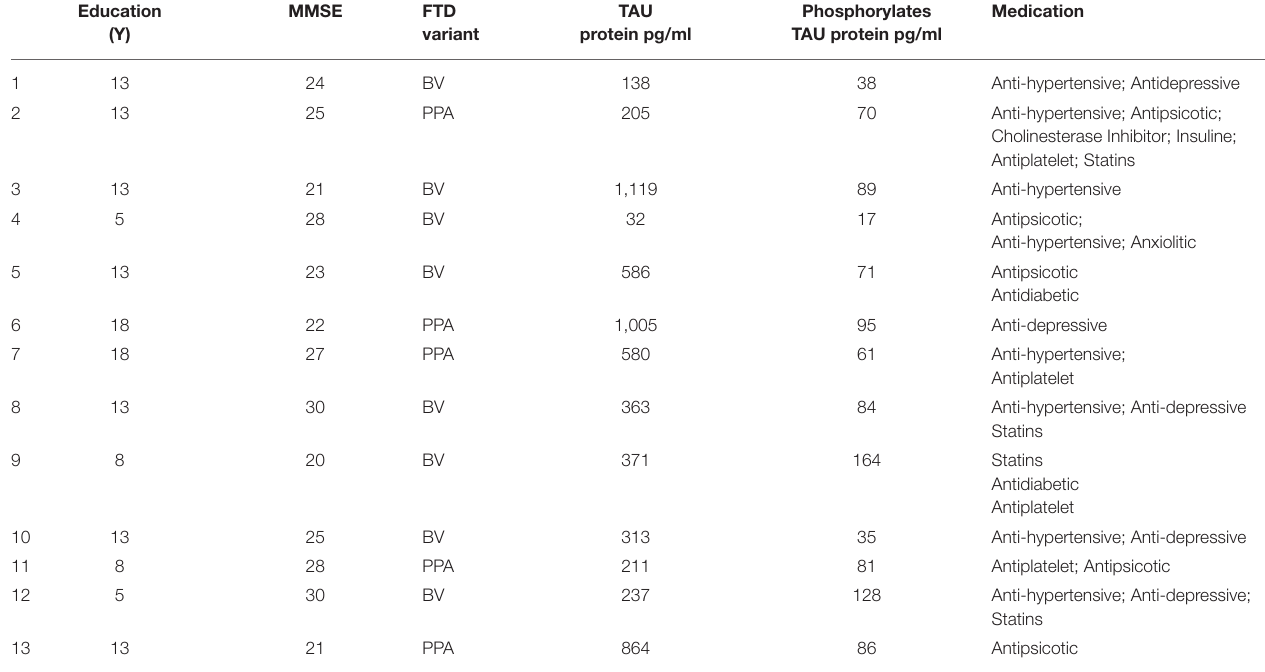
TABLE 1 | Demographic and clinical features of the enrolled patients. Education